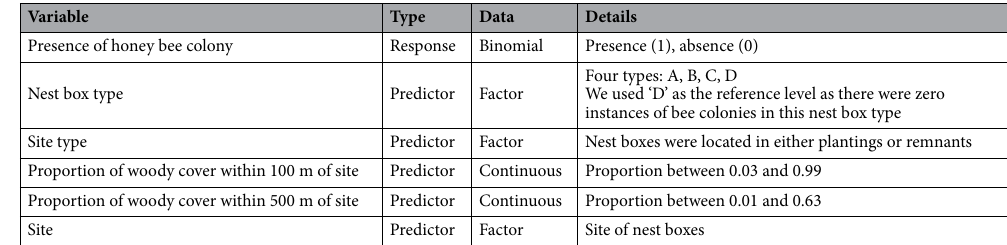
Table 3. Variables used in the statistical modelling.